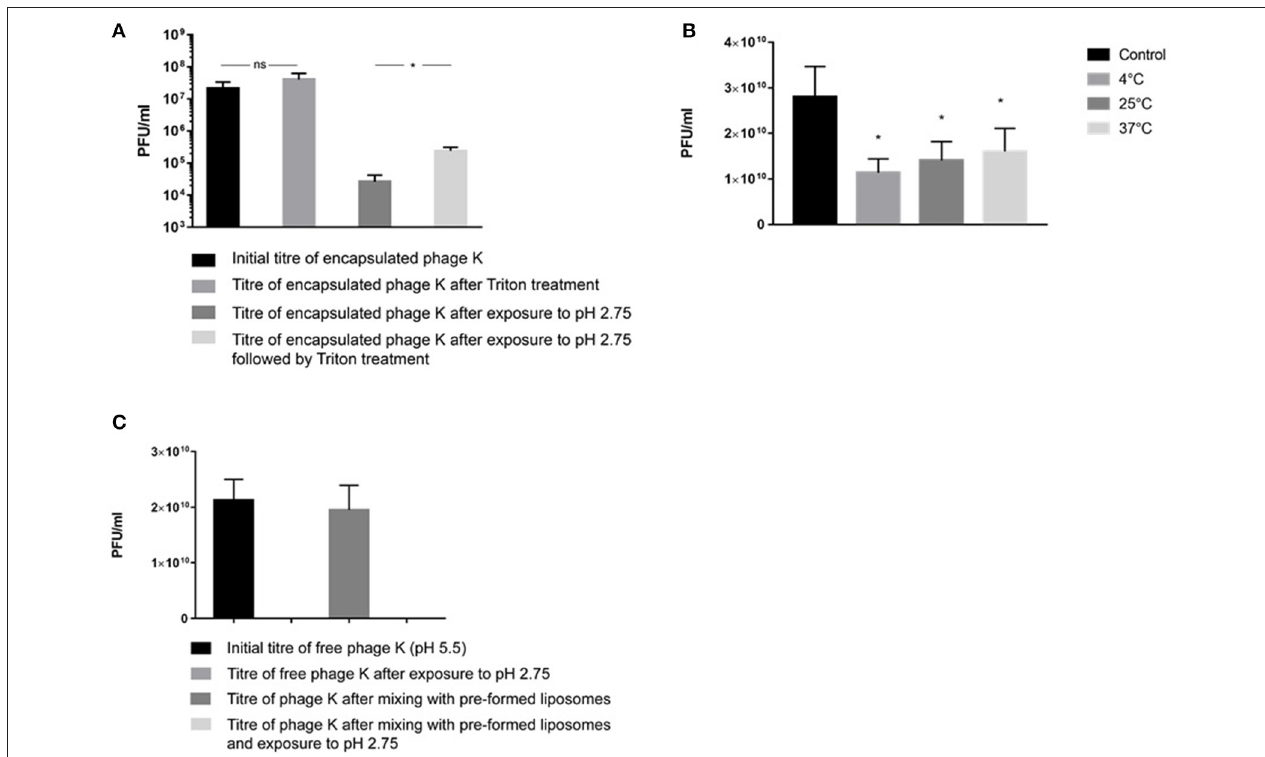
FIGURE 5 | (A) S. aureus phage K encapsulation in DSPC:cholesterol liposomes. Phages were encapsulated at FRR of 2:1 at room temperature. Phage titer of liposome encapsulated phages prior to and after acid exposure at pH 2.75 (with and without Triton X-100 disruption). *Indicates significance ( p < 0.05) using 2-sample t -test. (B) The titer of free phages in the supernatant before and after incubation with empty liposomes at 4, 25, and 37 ◦ C for 15min. After incubation, liposomes were separated by centrifugation at 13,000 × g for 3min and the phage titer in the supernatant was measured. The difference in the titer occurred due to phage adsorption onto the outer leaflet of bilayer membranes. The maximum phage adsorption was observed at 4 ◦ C, which caused the highest phage titer reduction in the supernatant at 4 ◦ C. The adsorption was still highly significant at 37 ◦ C. *Indicates significance ( p < 0.05) using 2-sample t -test of each sample compared with controls. (C) pH stability for free (non-encapsulated) phage K exposed to pH 2.75 and free phage K incubated with pre-made empty liposomes for 15min at 37 ◦ C and subsequently dialyzed at pH 2.75 for 60min. Error bars represent one standard